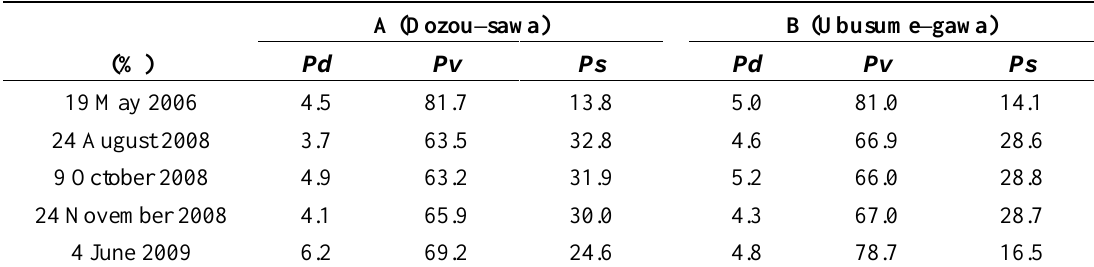
Table 3. Percentage of dominant scattering mechanism in areas associated with landslides following the 14 June 2008 Earthquake. A